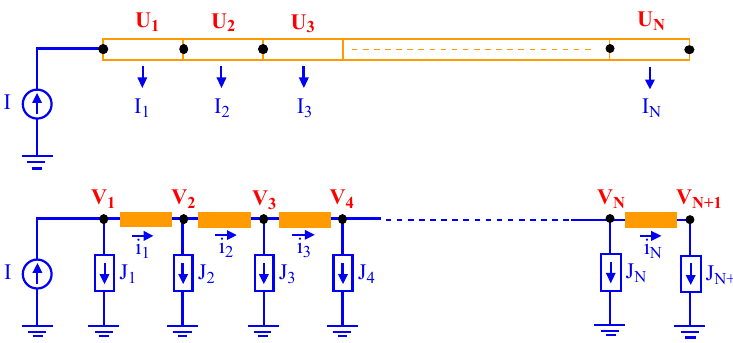
branch are displayed. At the bottom, the circuit-based model is shown. At each node of the circuit, the potential V t and the source of nodal leakage current J t are located. The internal currents i k that move inside the conductor are also shown.